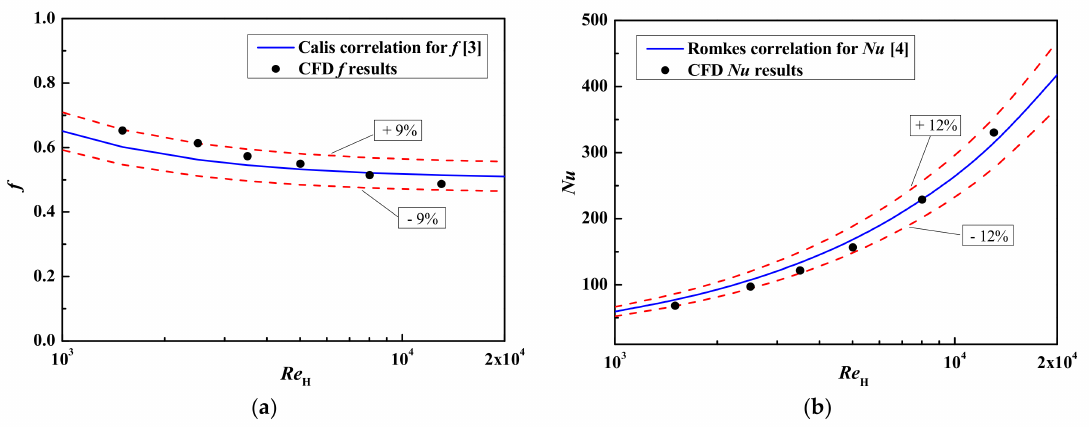
Figure 6. Validation of ( a ) friction factor; and ( b ) Nusselt number of the packed bed with smooth spheres at N = 1.00.